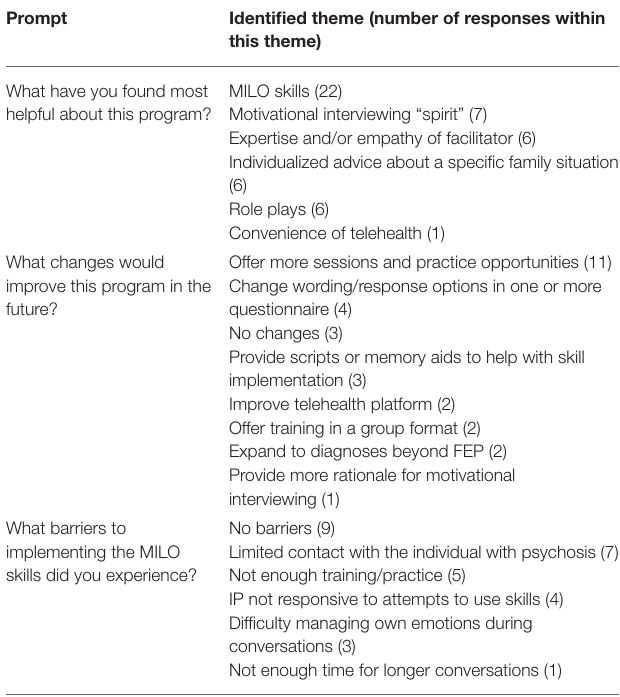
TABLE 4 | Qualitative response themes ( N =